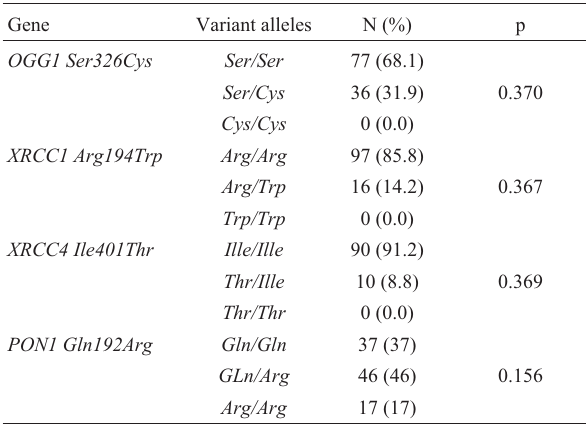
Table 5 - Distribution of genotypes and variant allele frequencies in the exposed